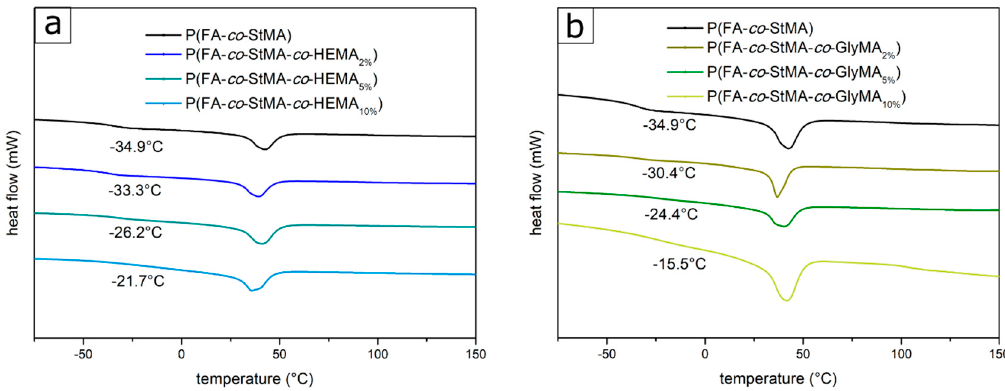
Figure 3. DSC thermogram of ( a ) the polymers copolymerized with HEMA with glass transition temperatures between − 34.9 and − 21.7 °C and a melting peak at a temperature of 38.1 °C and ( b ) the polymers copolymerized with GlyMA with glass transition temperatures between − 34.9 and − 15.5 °C and a melting peak at a temperature of 38.1 °C. For polymer P(FA- co -StMA- co -BPMA) (batch eight and nine), a displacement of the